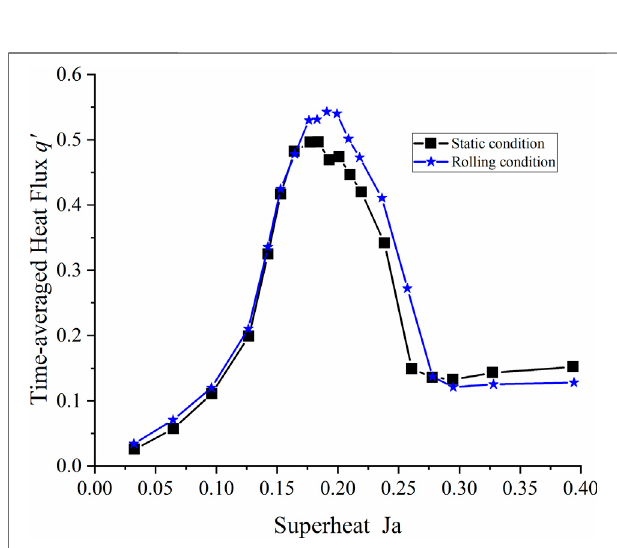
FIGURE 3 | Boiling curve of pool boiling under static and rolling